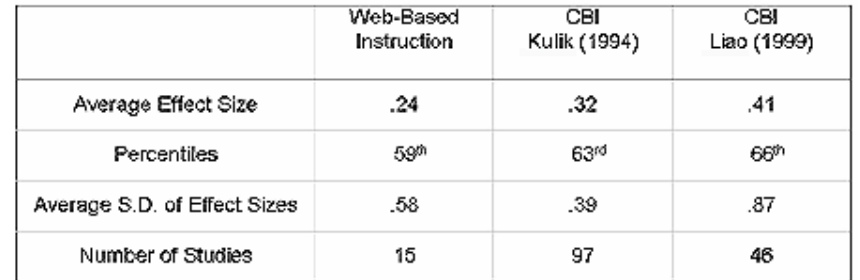
Table 5. Comparison of effect sizes across